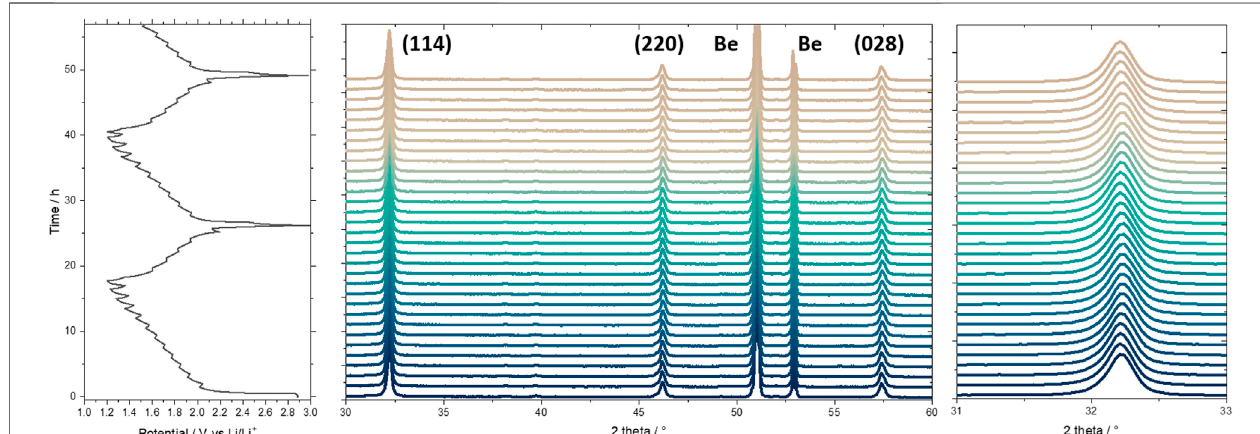
FIGURE 6 | In situ XRD patterns of the Ag 0.70 La 0.10 □ 0.20 NbO 3 at a current of 0.02 A g − 1 with corresponding voltage-time